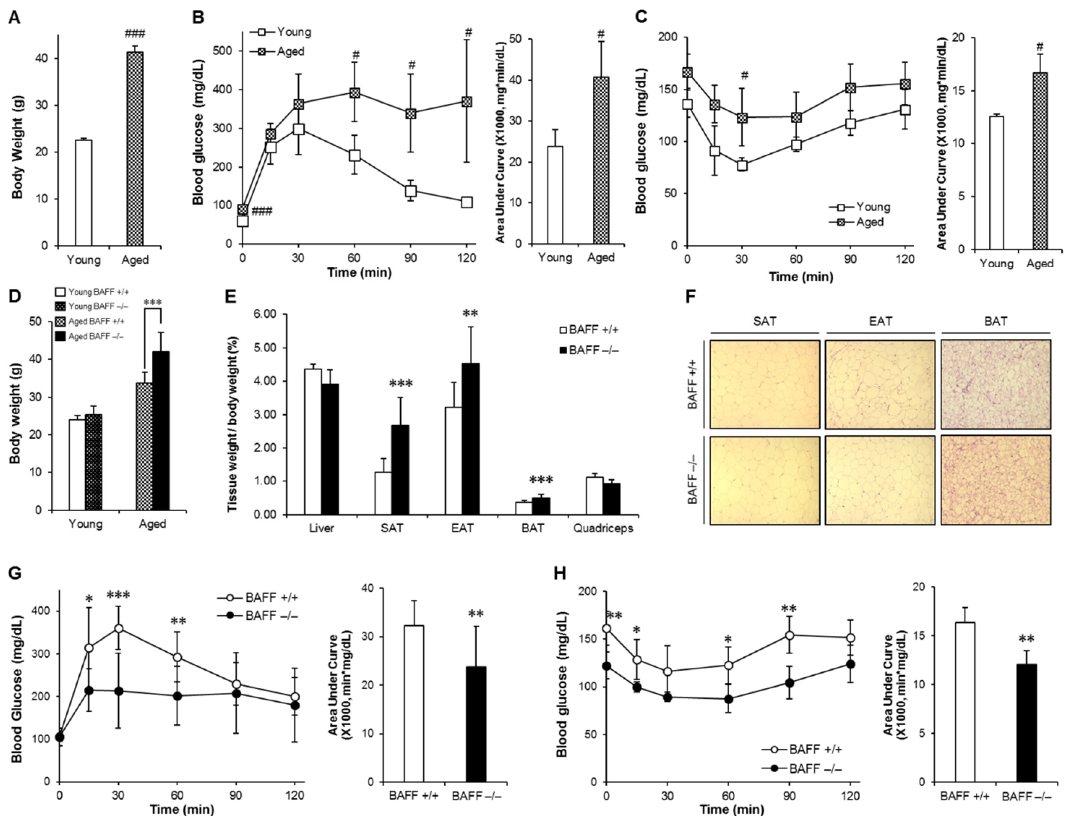
Figure 1. Aging aggravates insulin resistance and aged BAFF -/- (B-cell-activating factor) mice shows enhanced glucose tolerance despite increased body weight. Young and old mice were maintained on a normal chow diet for 2 months and 10 months, respectively. Changes of ( A ) body weight, ( B ) glucose tolerance and ( C ) insulin sensitivity were measured ( n = 5). Mice fasted for 16 h, and the blood glucose levels were measured at 0, 15, 30, 60, 90 and 120 min after intraperitoneal injection of glucose (2 g/kg) or insulin (0.5 U/kg). BAFF -/- and C57BL/6J mice were maintained on a normal chow diet for 10 months. ( D ) Body weights of 2- and 10-month-old adult male mice ( n = 4–12). ( E ) Tissue weights of 10-month-old mice ( n = 9–12). ( F ) Hematoxylin and eosin (H&E) staining sections of adipose tissues. Adipose tissues were fixed in 10% v/v formalin/PBS, and then embedded in paraffin for staining with hematoxylin and eosin. Images were obtained under a microscope at a magnification of X100. ( G and H ) Glucose tolerance test and insulin tolerance test of 10-month-old male mice ( n = 8–12). Data represent means ± SD. # p < 0.05 and ### p < 0.001 between young and old mice and * p < 0.05, ** p < 0.01, *** p < 0.001 between wild-type and BAFF -/- mice. SAT: subcutaneous adipose tissue, EAT: epididymal adipose tissue, BAT: interscapular brown adipose tissue.